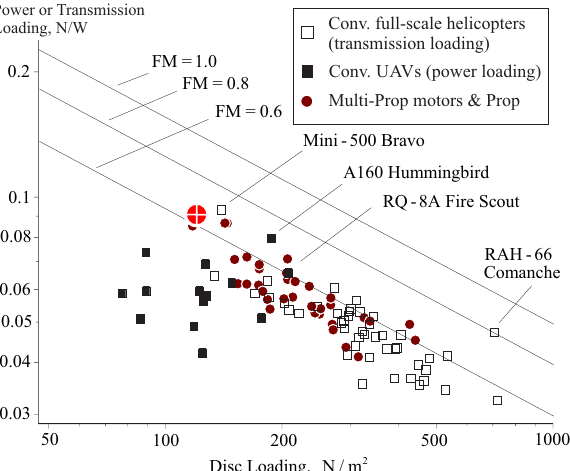
Figure 16. Power loading vs. disc loading and lines of constant Figure of Merit,